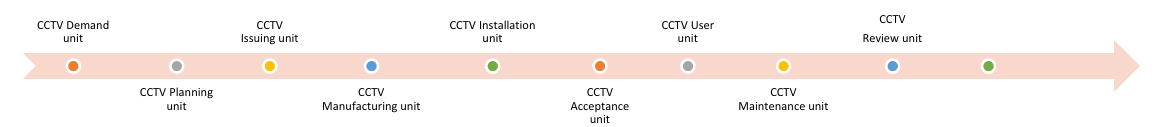
Figure 8. Types of ownership units.